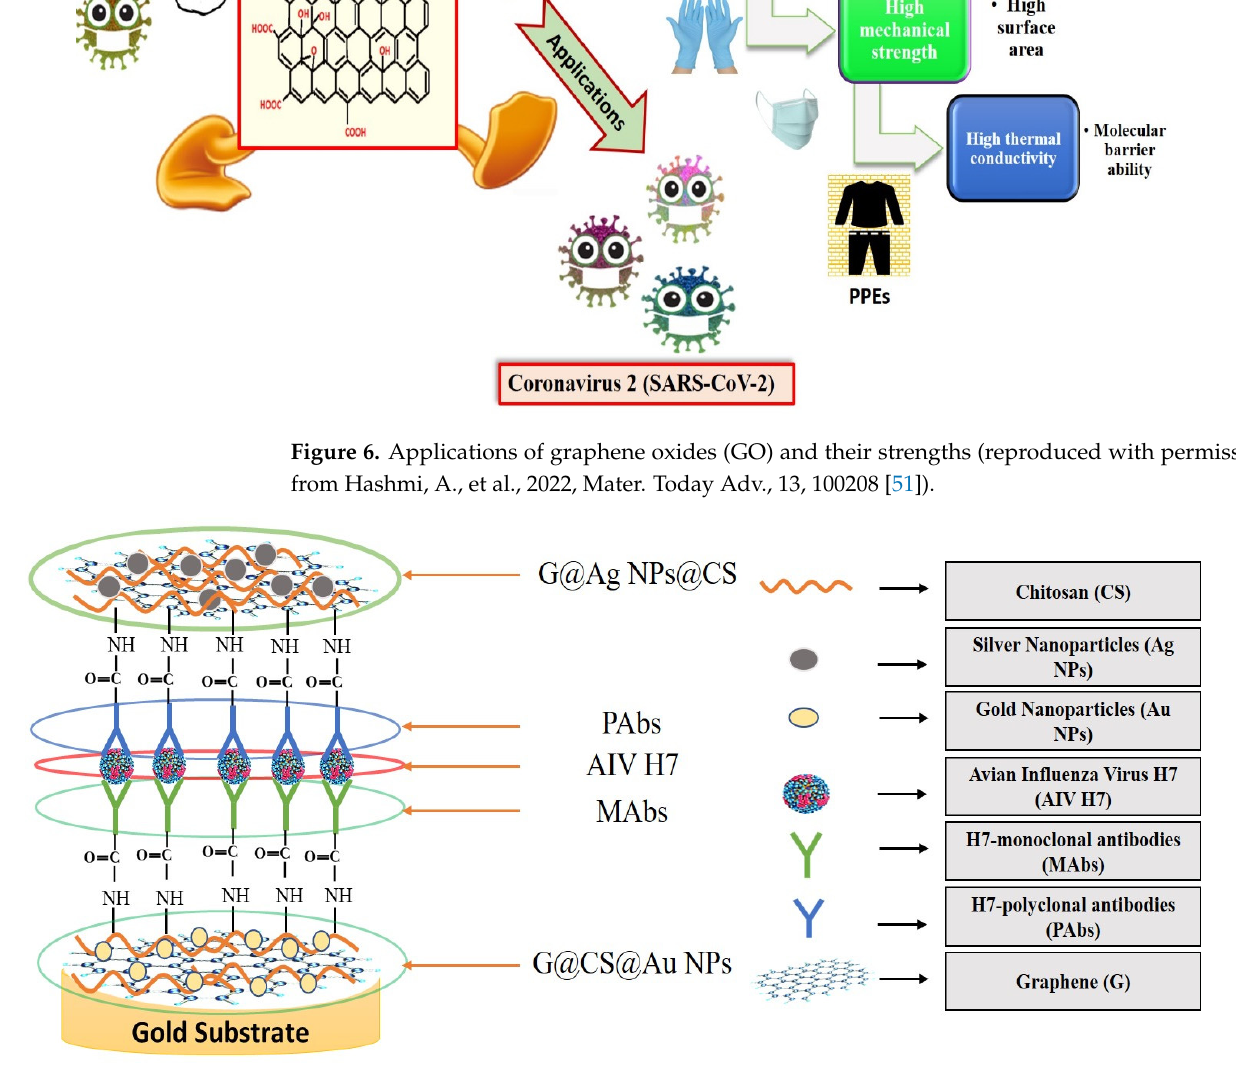
Figure 7. Illustration of sandwich-type immunosensor for determination of avian influenza virus H7 (reproduced with permission from Hashmi, A. et al., 2022, Mater. Today Adv., 13, 100208 [51]). Similarly, Zhong, et al. reported graphene masks with ultra-hydrophobic and photothermal performance to fight the SARS-CoV-2 virus because the